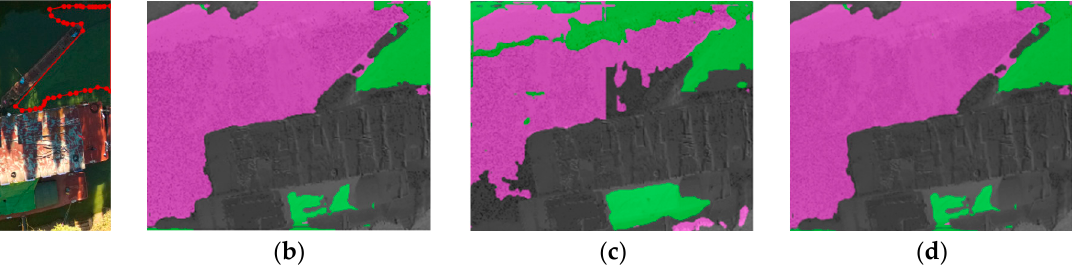
Figure 9. Detection results of different deep-learning algorithms for shadow scene: ( a ) visible light images; ( b ) detection results of FCN; ( c ) detection results of SegNet; ( d ) detection results of improved transformer model.